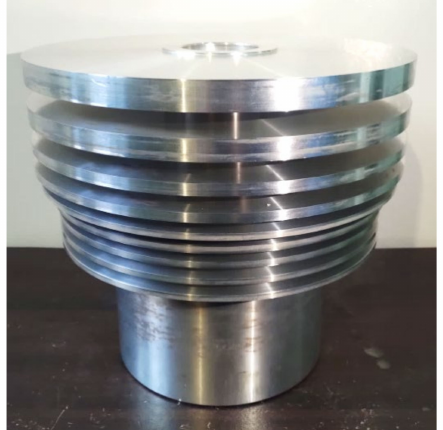
Figure 9. Blank of AL6061-T6 after